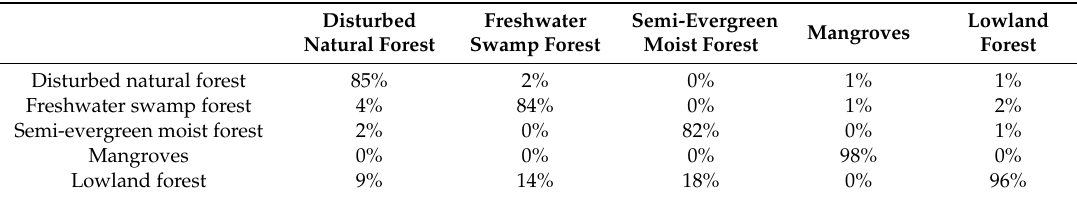
Table 3. Error matrix for RF classification of forest type for the most accurate classification